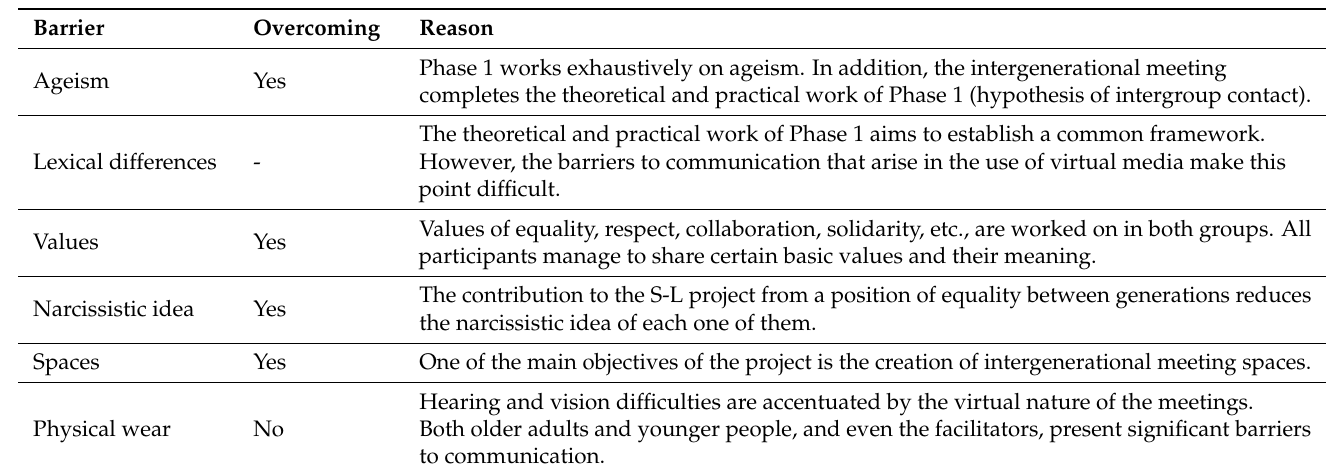
Table 4. Overcoming barriers to intergenerational communication in the